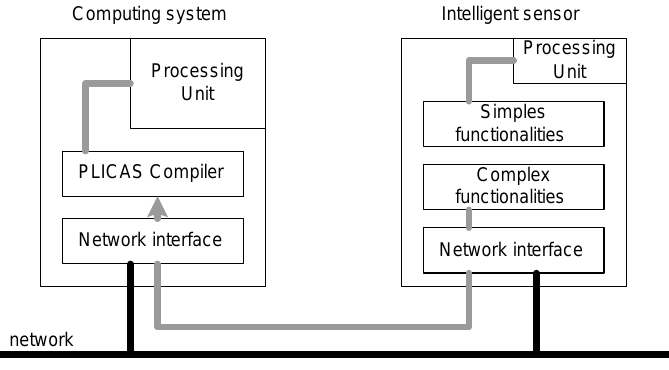
Figure 7. Concept of intelligent fuzzy sensor with small processor